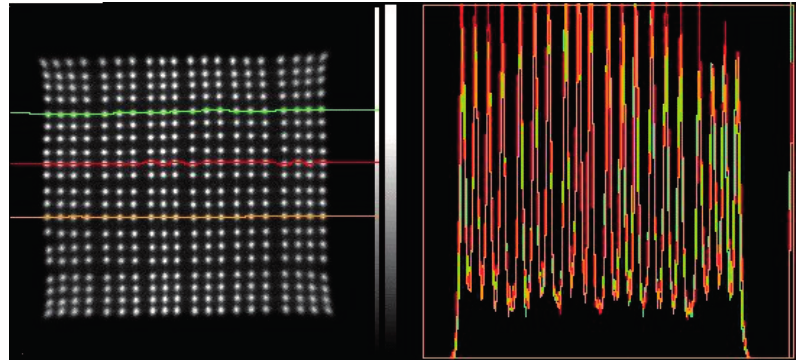
Figure 3. Crystal identification map from an Inveon 400 LSO crystal pre-clinical PET